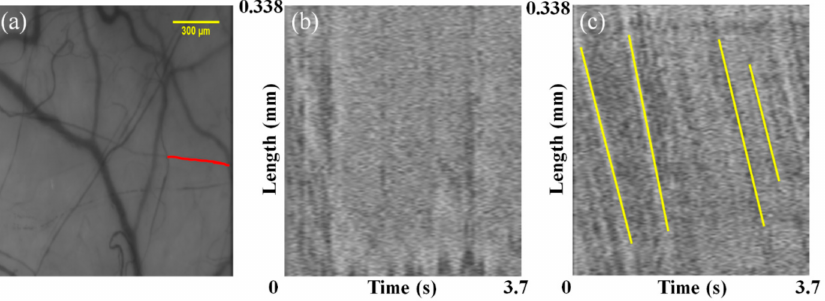
Figure 8. ( a ) Vessel used to generate the STA image (red line). ( b ) STA image before motion correction. ( c ) STA image after motion correction. Yellow lines represent slopes, which indicate blood flow velocity.